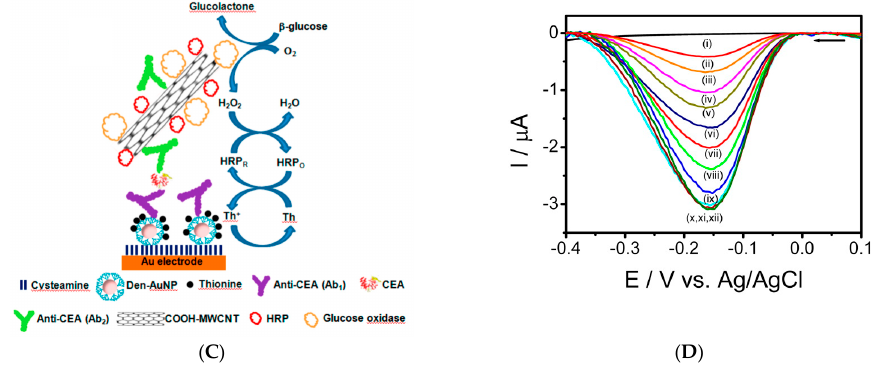
Figure 32. ( A ) PAMAM-based electrochemical immunosensor for detection of α -SYN. ( B ) Calibration curves obtained with {HRP-Ab 2 -GNPs}/Ab 1 / α -SYN/Th/PAMAM-Au/ o -ABA/GCE immunosensor for different concentrations of α -SYN. Inset: (a) amperometric responses of the immunosensor in PBS (pH 6.5) to α -SYN at various concentrations of (a) 0, (b) 0.05, (c) 0.1, (d) 0.2, (e) 0.5 ng mL − 1 ; (b) amplification